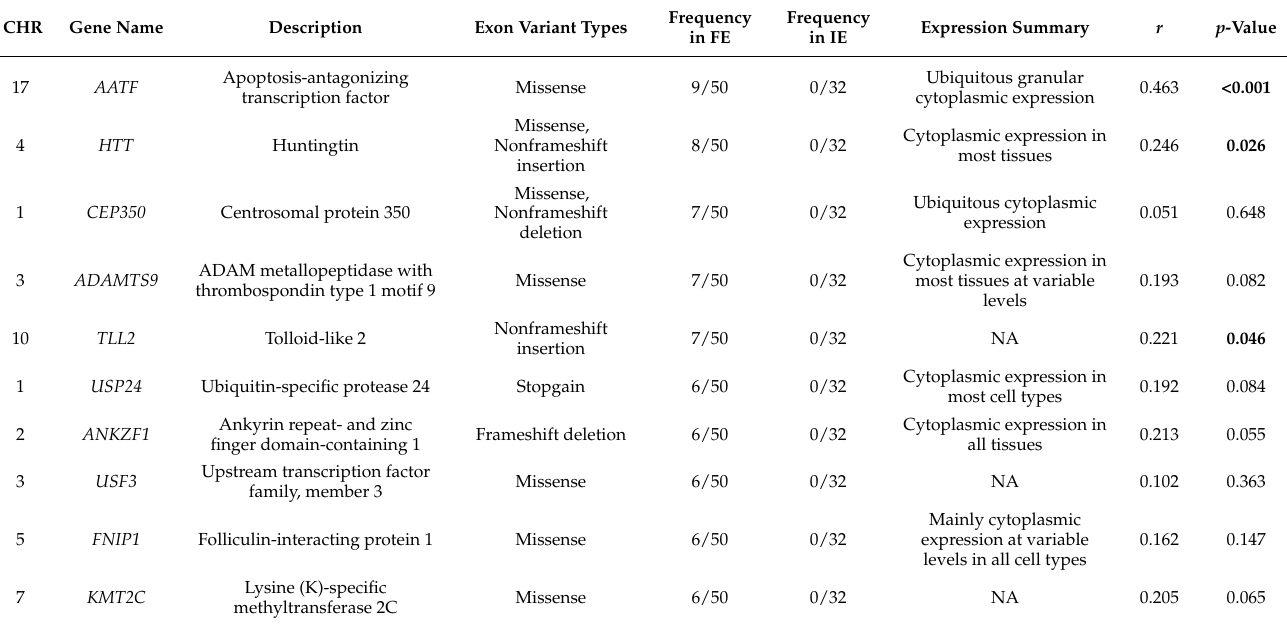
Table 2. The top 10 mutated genes were only detected in the FE group.